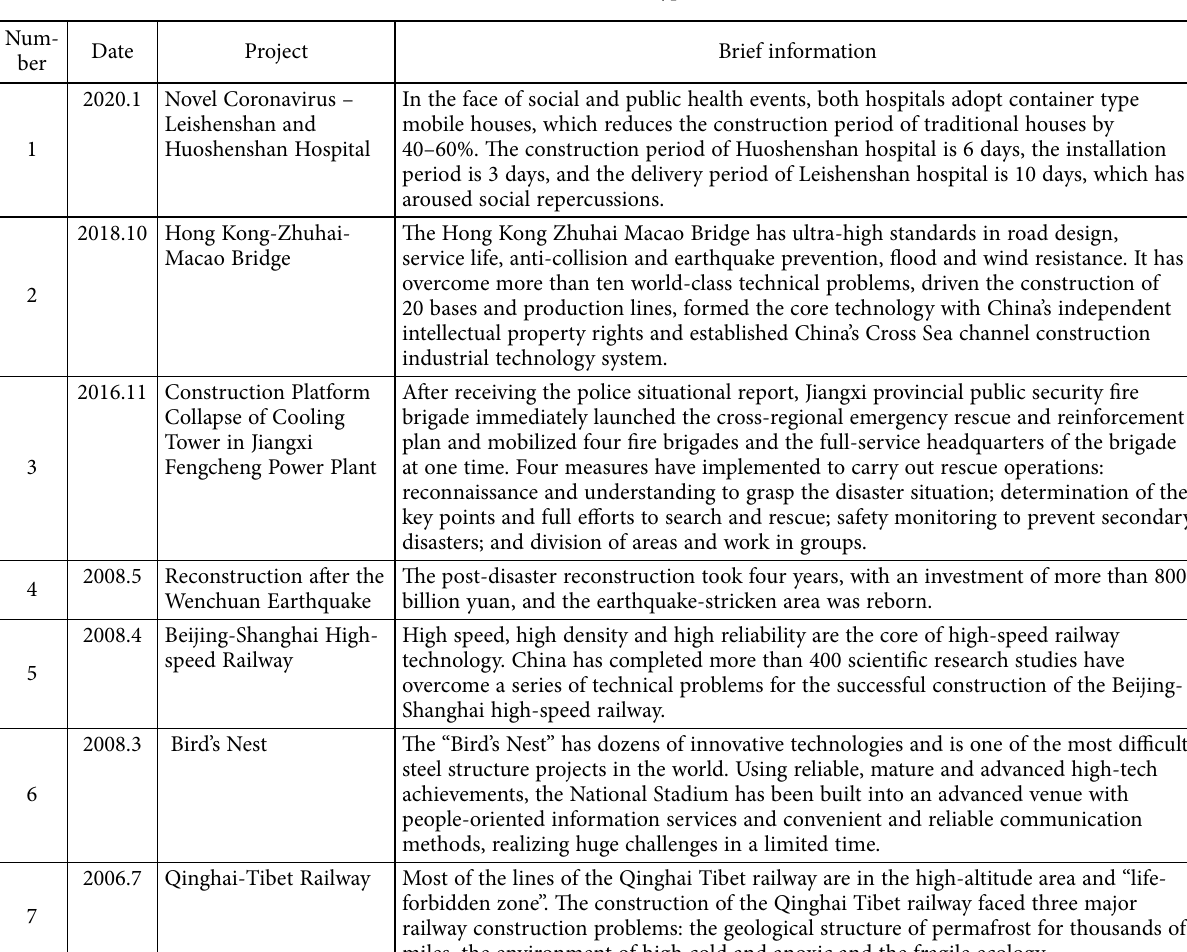
Table 1. The base of 15 typical